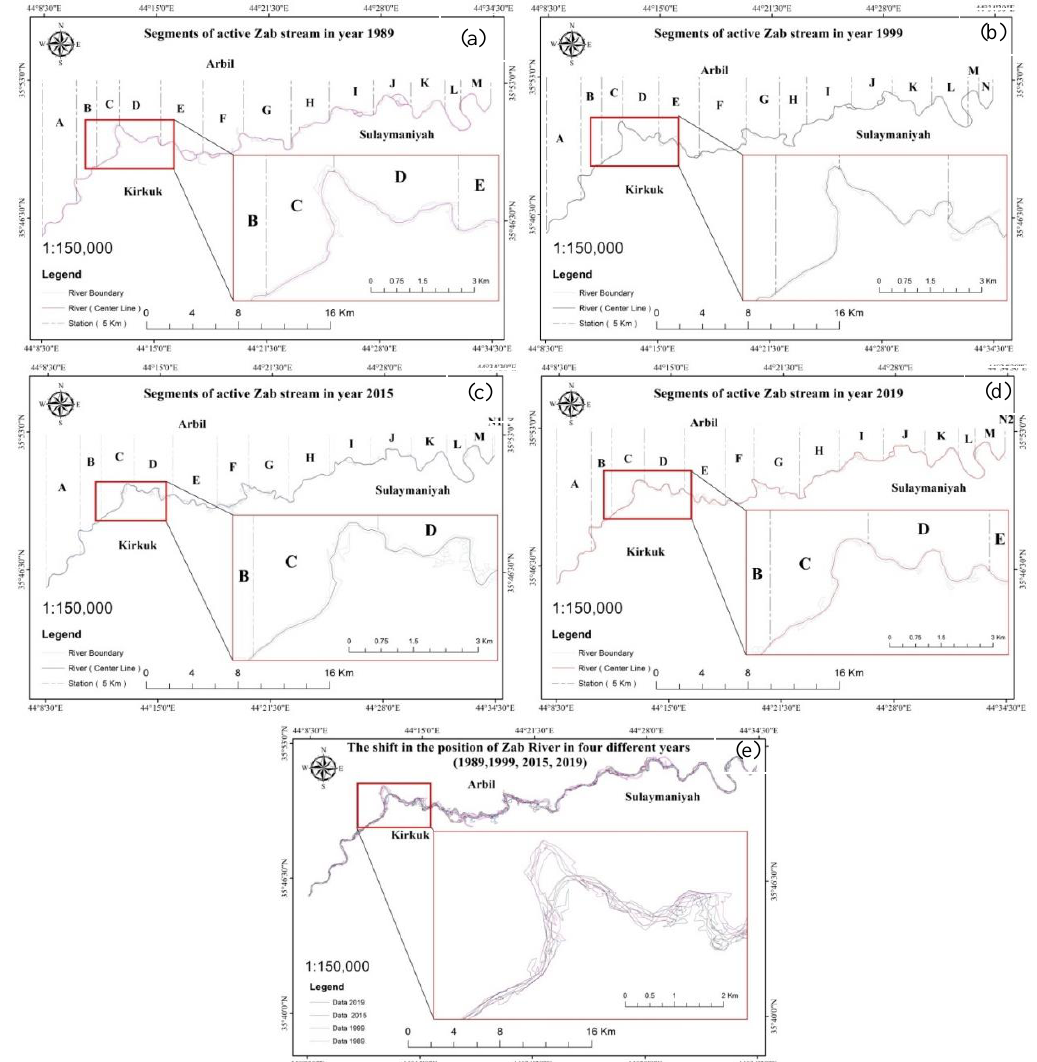
Figure 2. Segments of active Zab stream in years a)1989, b)1999, c) 2015, d) 2019, e) the shift in the position of Zab River in four different years (1989, 1999, 2015,